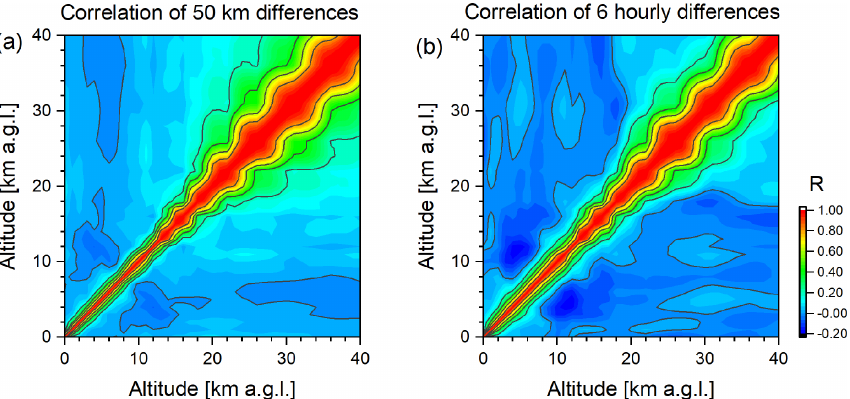
Figure E2. Characteristics of the vertical dependencies covered by the matrices S l difference between the reference CH 4 profile (location 49.1 ◦ N, 8.4 ◦ E, corresponding to the location of Karlsruhe) and profiles dislocated with respect to the reference: (a) horizontal dislocation of 50km and (b) temporal dislocation of